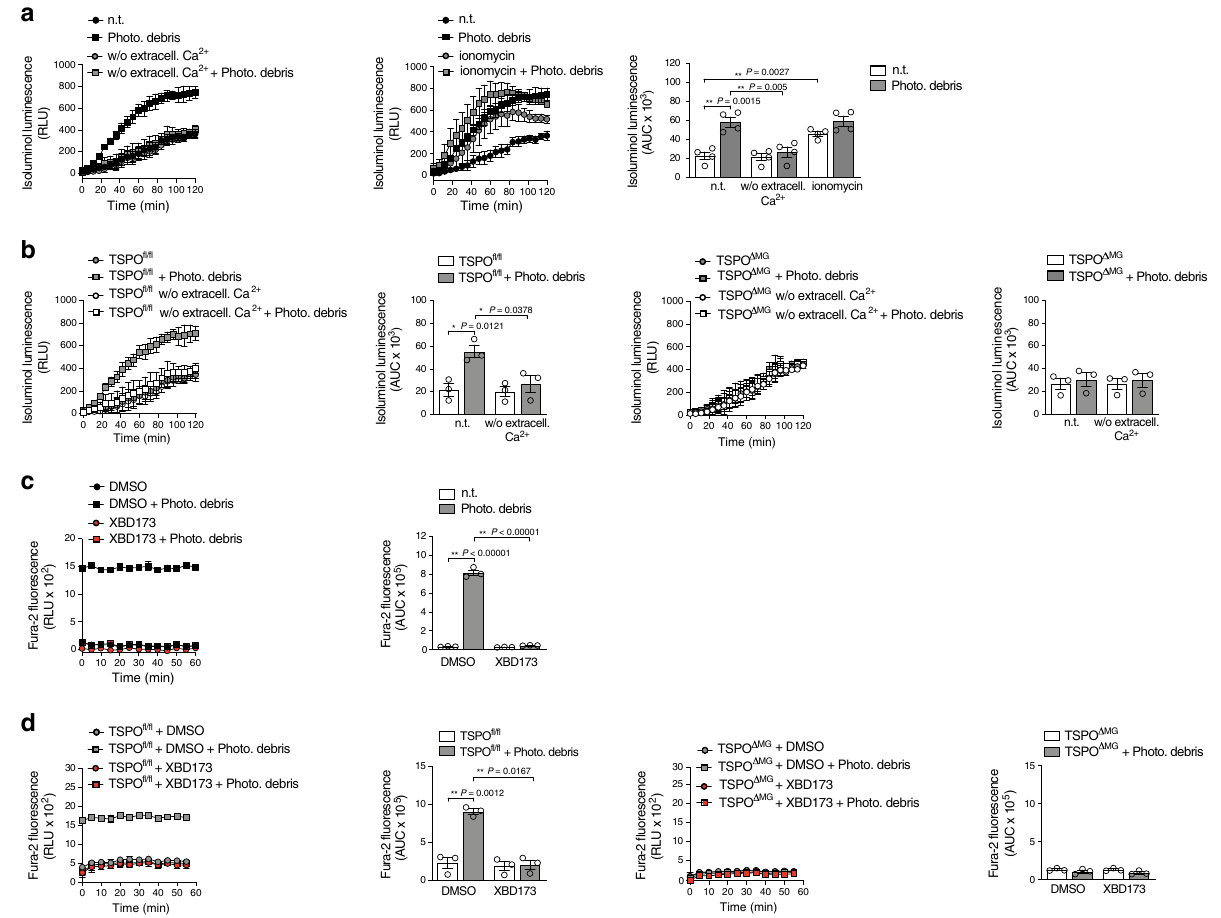
Fig. 6 TSPO associated increase in cytosolic calcium is essential for Nox1-derived extracellular ROS production. a and b Quanti fi cation of extracellular ROS production by primary microglia from WT a , TSPO fl / fl , and TSPO Δ MG mice b . Kinetics of ROS production and the area under the curve (AUC) are shown. Where indicated, primary microglia were stimulated with photoreceptor cell debris and cytosolic Ca 2 + was increased with the Ca 2 + ionophore ionomycin as a positive control. n = 4 a , 3 b independent experiments. c and d Quanti fi cation of cytosolic calcium levels in primary microglia from WT c , TSPO fl / fl , and TSPO Δ MG mice d . Where indicated, primary microglia were stimulated with photoreceptor cell debris. n = 3 independent